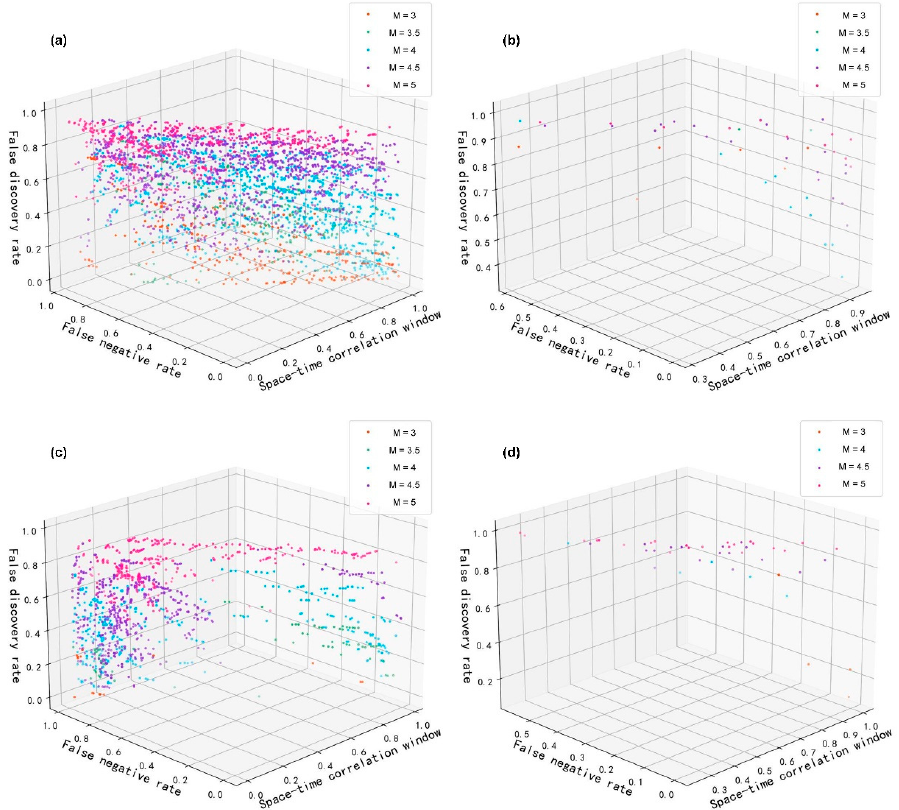
Figure 8. Comparison of the results of resampling experiments for parameters that pass the signifi- cance tests of FNR and FDR simultaneously under different magnitude parameters: ( a ) the model with a “heating core” when the resampling scale is 50, where a total of 3459 sets of parameters pass the test; ( b ) the model without a “heating core” when the resampling scale is 50, where a total of 50 sets of parameters pass the test; ( c ) the model with a “heating core” when the resampling scale is 100, where a total of 1337 sets of parameters pass the test; ( d ) the model without a “heating core” when the resampling scale is 100, where a total of 48 sets of parameters pass the test.